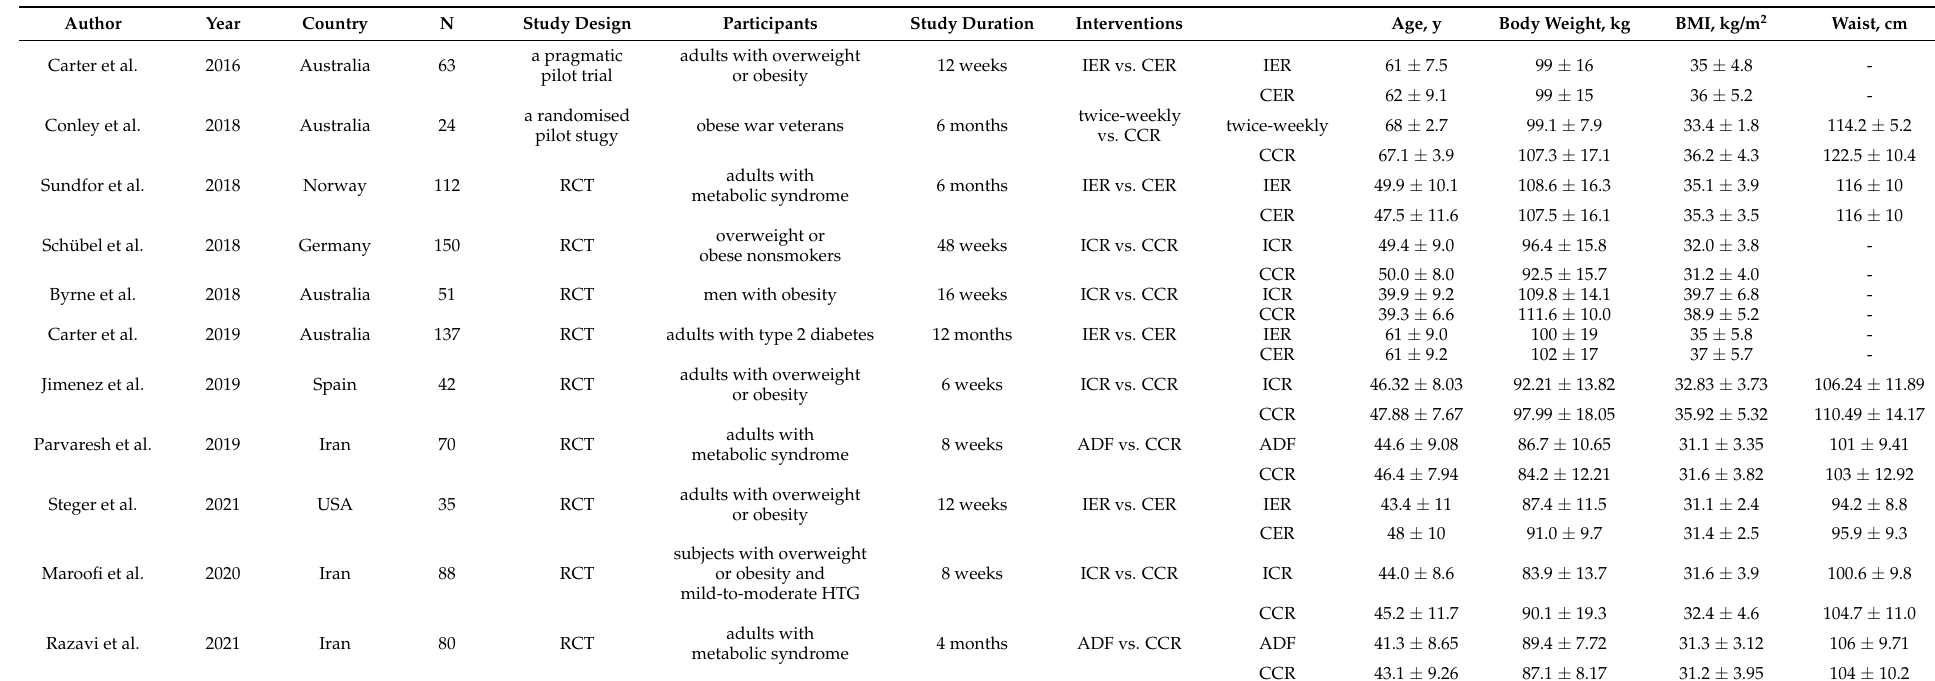
Table 1. Characteristics of included